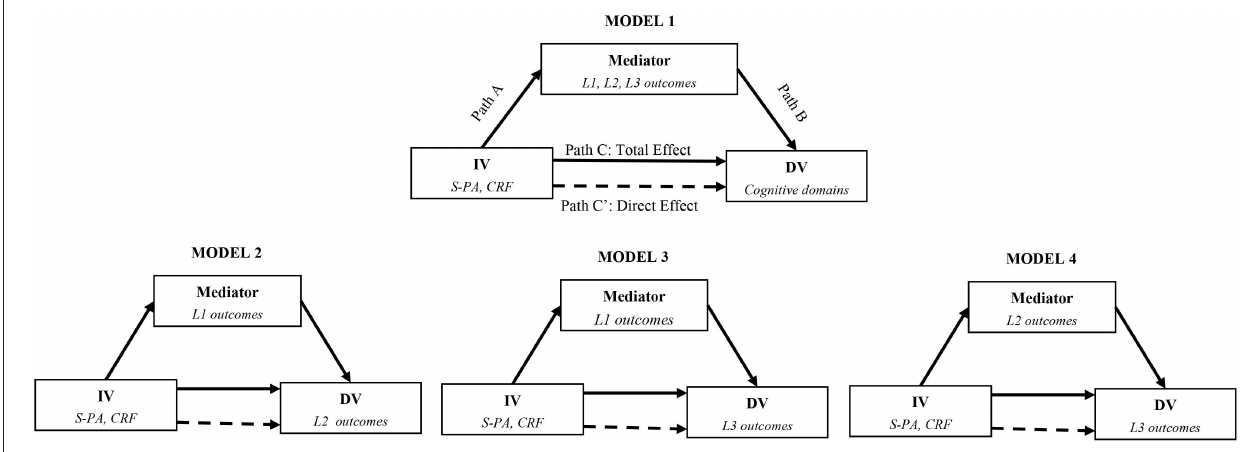
FIGURE 1 | Mediating models.